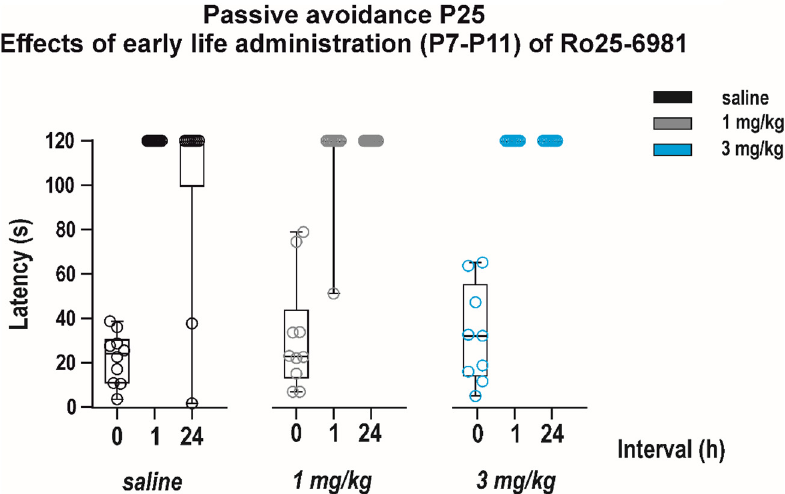
Figure 8. Effects of early life administration of Ro25-6981 on performance in the passive avoidance test. The drug was administered as described above at P7–P11 in dose 1 and 3 mg/kg i.p. Animals (experimental groups consisted 9–10 animals) were tested at P25; i.e., 14 days after treatment cessation, and the test was repeated three times (for details, see Figure 6). None of the tested doses influenced the performance of animals in this test, suggesting that early life exposure to Ro25-6981 does not impair cognitive abilities later in maturation. All details and symbols as in Figures 4 and 6.